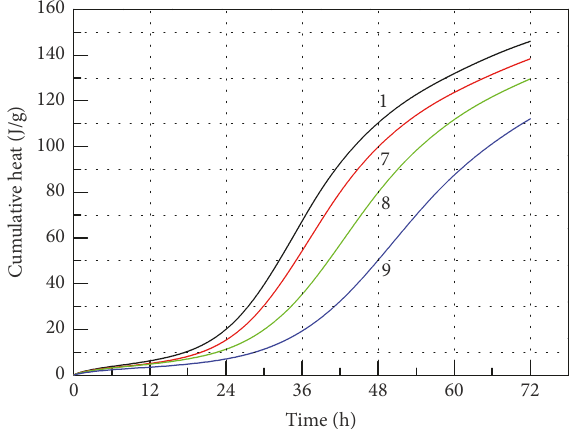
Figure 17: Cumulative heat versus time of references with SRA.